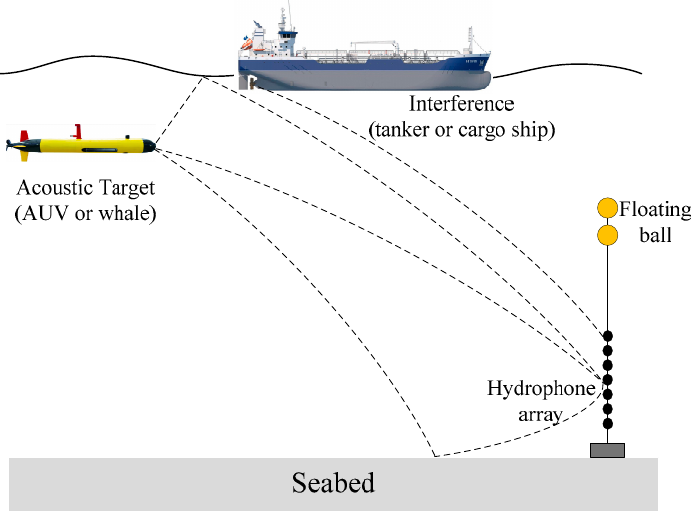
Figure 1. A schematic of an acoustic target (autonomous underwater vehicle or a whale) masked by a ship (a tanker or a cargo ship). The dashed lines represent the propagation paths from the sources to the hydrophone VLA.